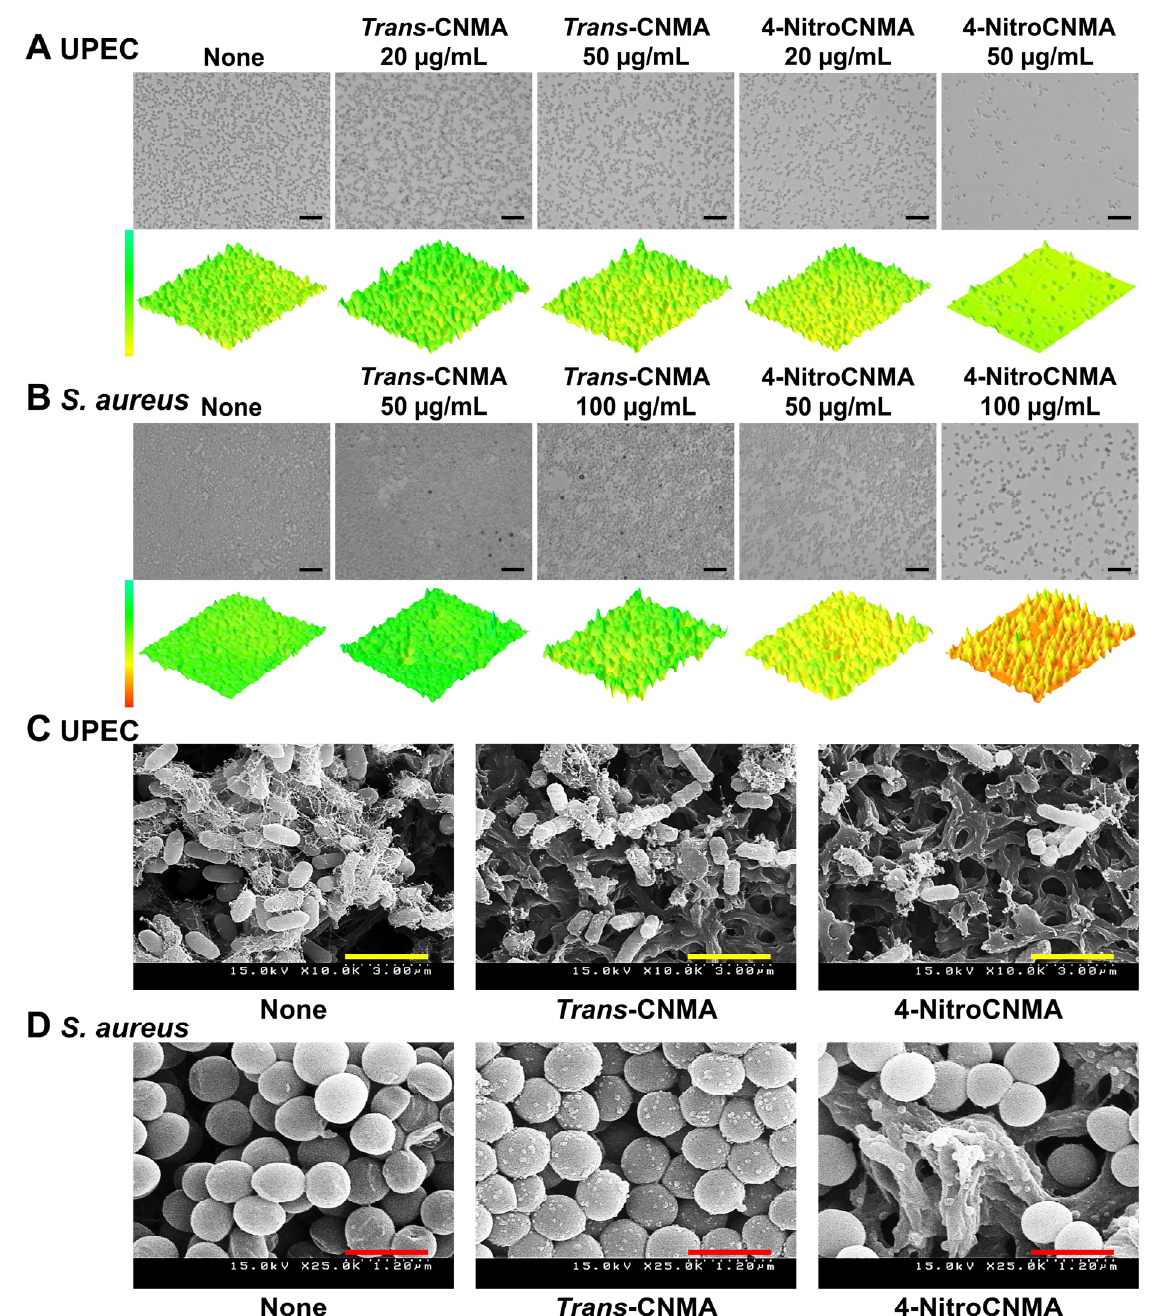
Figure 3. Microscopic observations of biofilm inhibition by trans -CNMA and 4-nitroCNMA. The 3D optical microscopy images of biofilm formation by UPEC ( A ) or S. aureus ( B ) in the presence or absence of trans -CNMA or 4-nitroCNMA. Black scale bars indicate 10 µm. SEM images of UPEC ( C ) and S. aureus ( D ) biofilms formed in the presence or absence of trans -CNMA and 4-nitroCNMA at 50 µg/mL. Yellow and red scale bars indicate 3 and 1.2 µm, respectively.